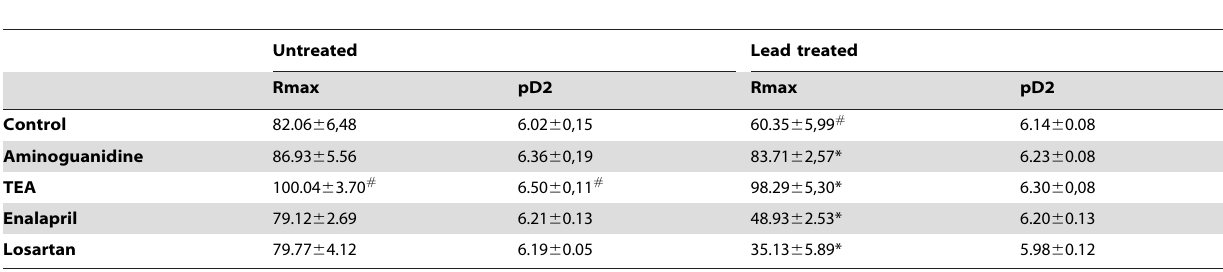
Table 2. Effects of aminoguanidine, TEA, losartan and enalapril on the vascular responses to phenylephrine (R max and pD 2 ) in aortas from untreated and lead-treated rats.